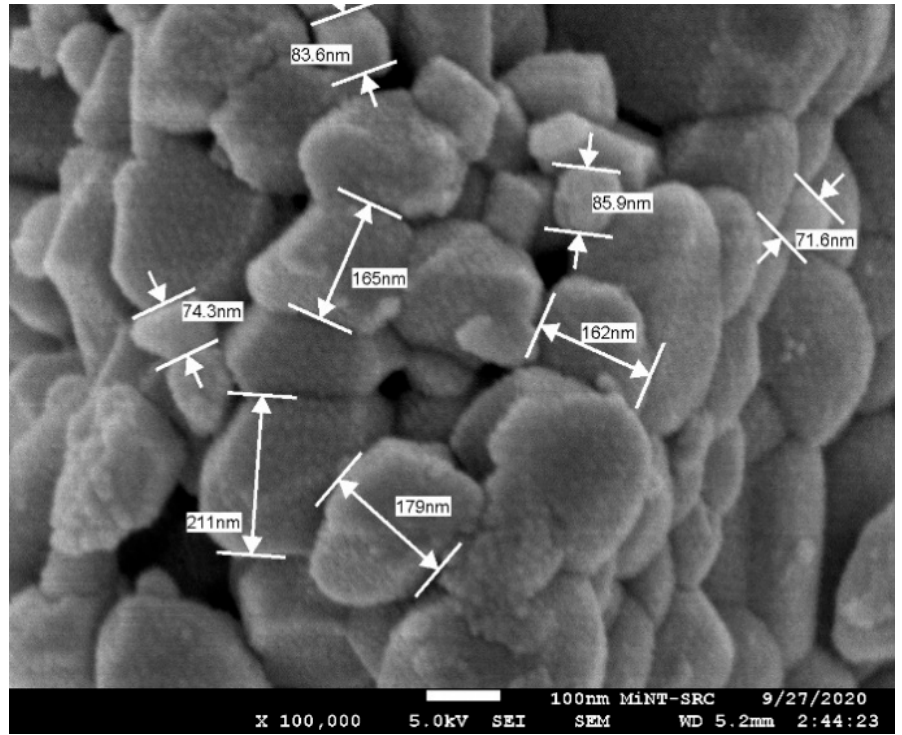
Figure 1. ZrO 2 nanoparticle size and shape.